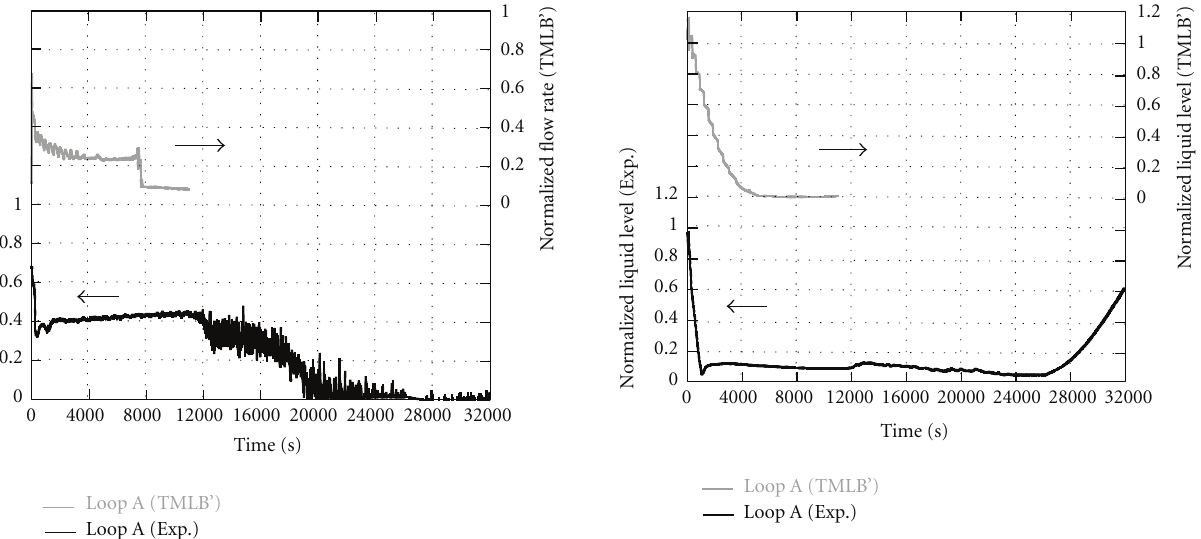
Figure 25: Comparison with TMLB’ scenario test results for primary mass flow rate in loop with PZR.